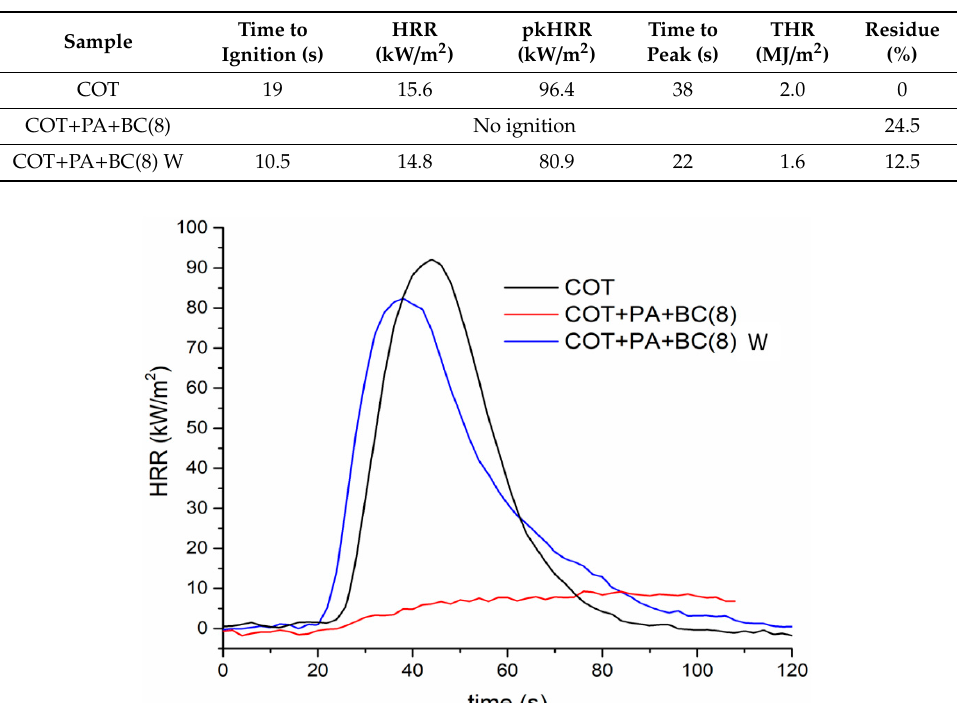
Figure 11. HRR vs. time curves for cotton and for COT + PA + BC(8) before and after washing (heat flux: